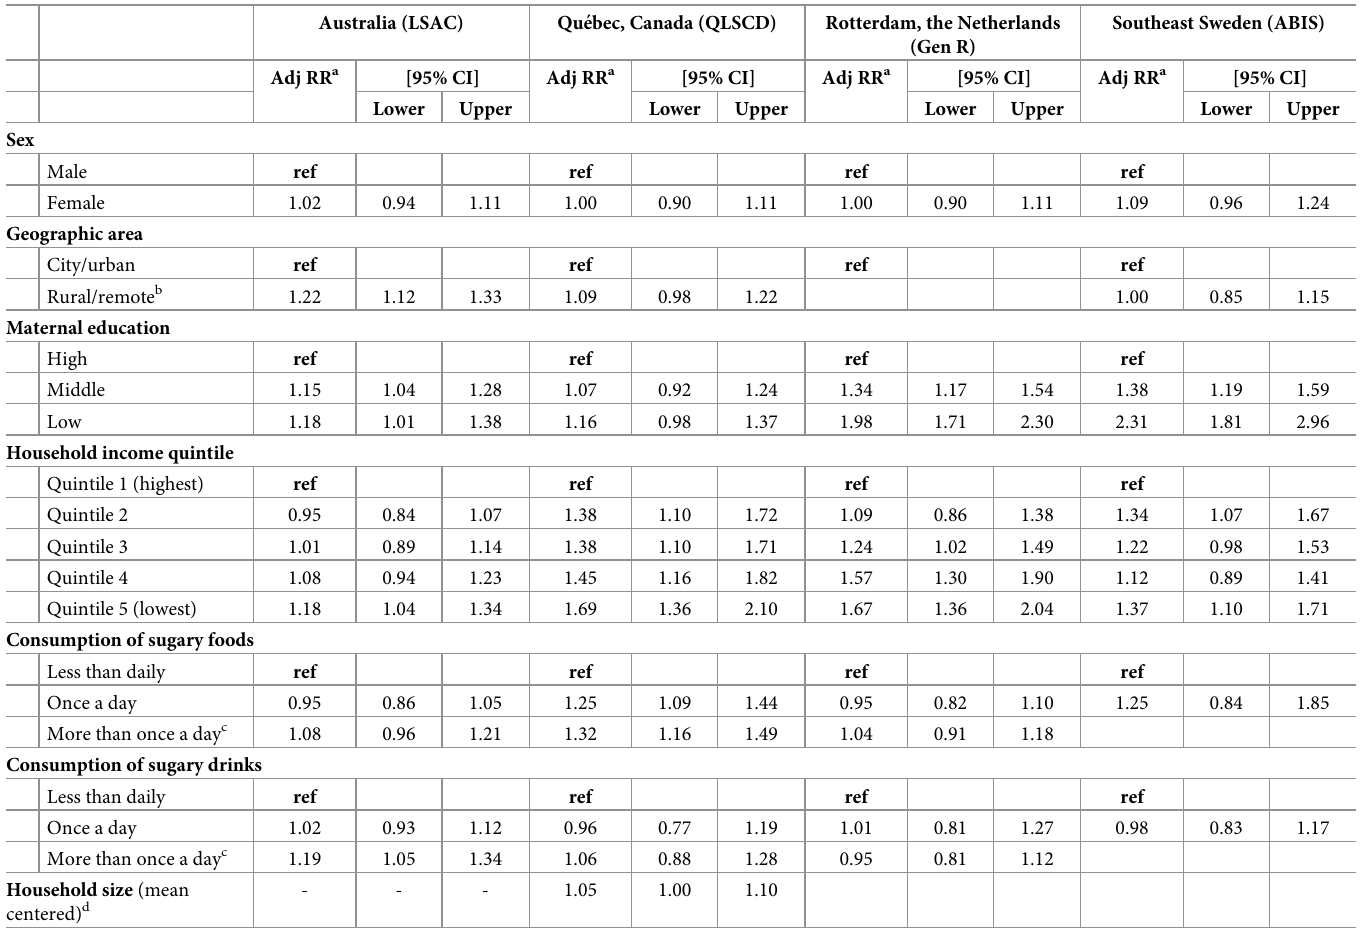
Table 3. Adjusted risk ratios for child dental